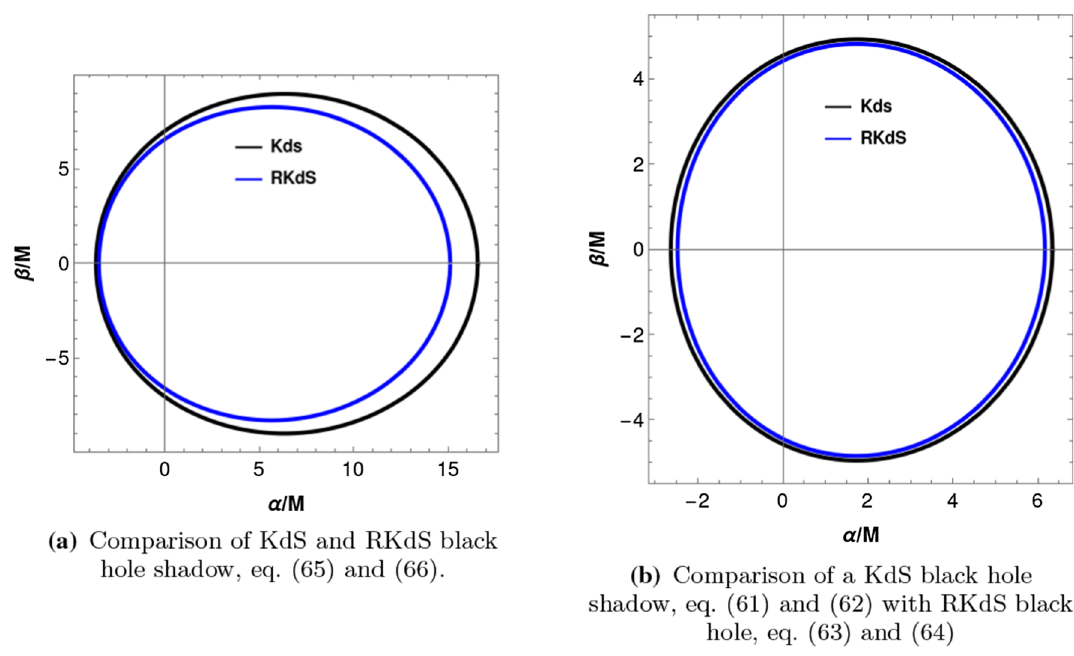
Fig. 7 Plots comparing the size of a KdS with RKdS black hole shadow for a = 0 . 9, M = 1 . 06, θ = π/ 2 and (cid:2) = 0 . 06 m − 2